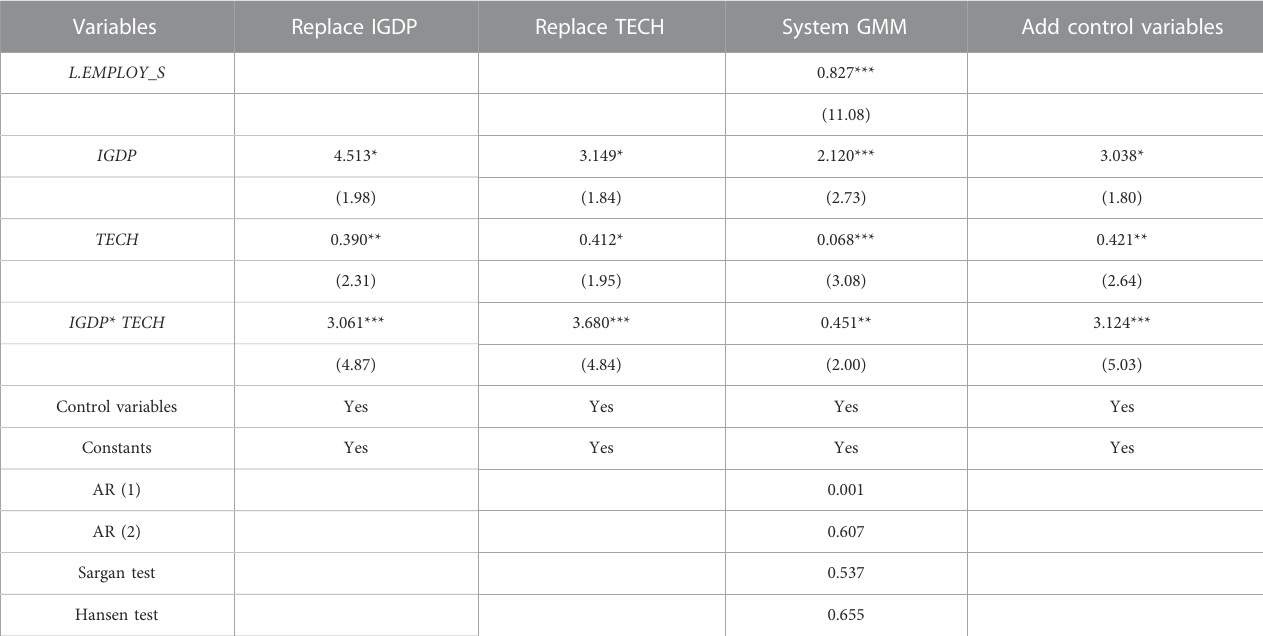
TABLE 7 Robustness test results